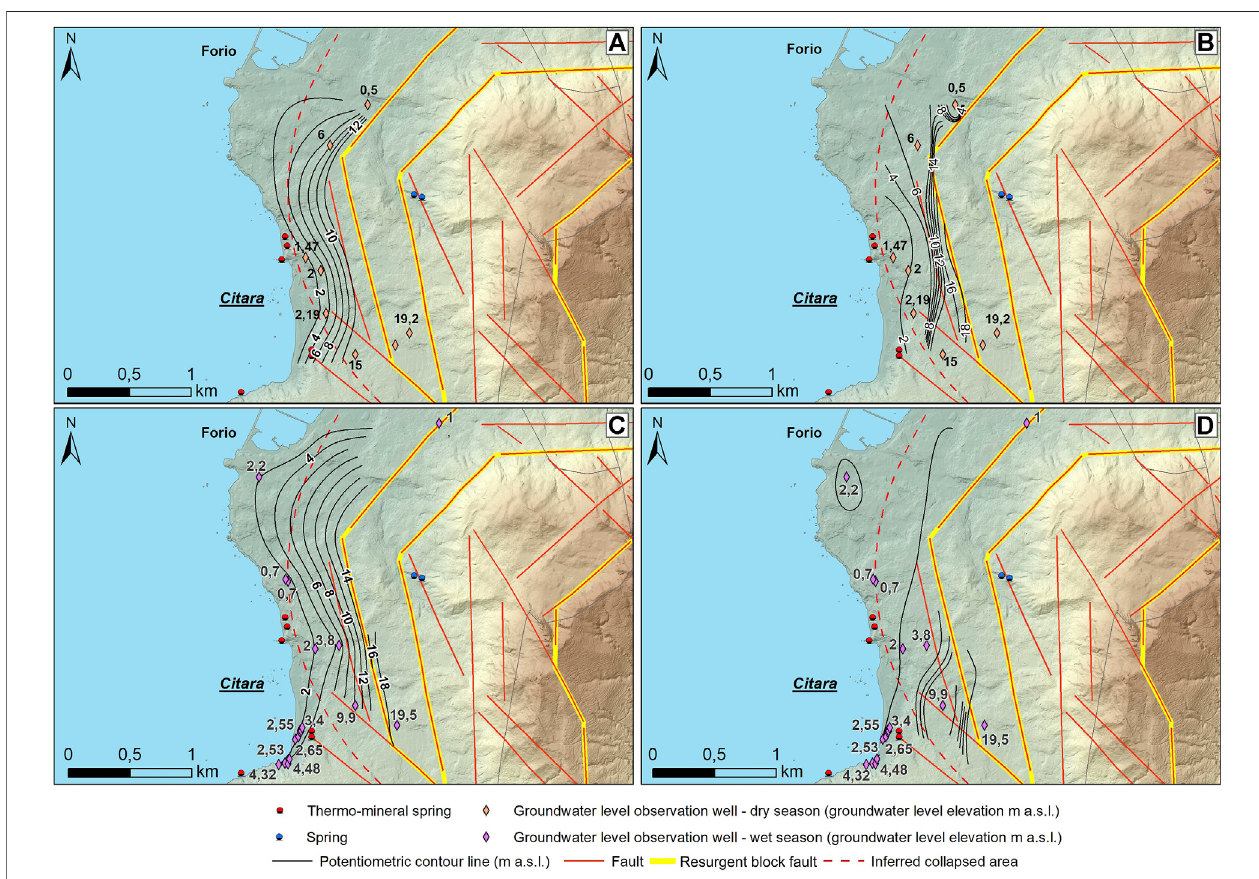
FIGURE7| PiezometricsurfacemapoftheCitarasector: (A) NaNinterpolation(dryseason); (B) IDWinterpolation(dryseason); (C) NaNinterpolation(wetseason); (D) IDW interpolation (wet season). DEM details are in Figure 2 .